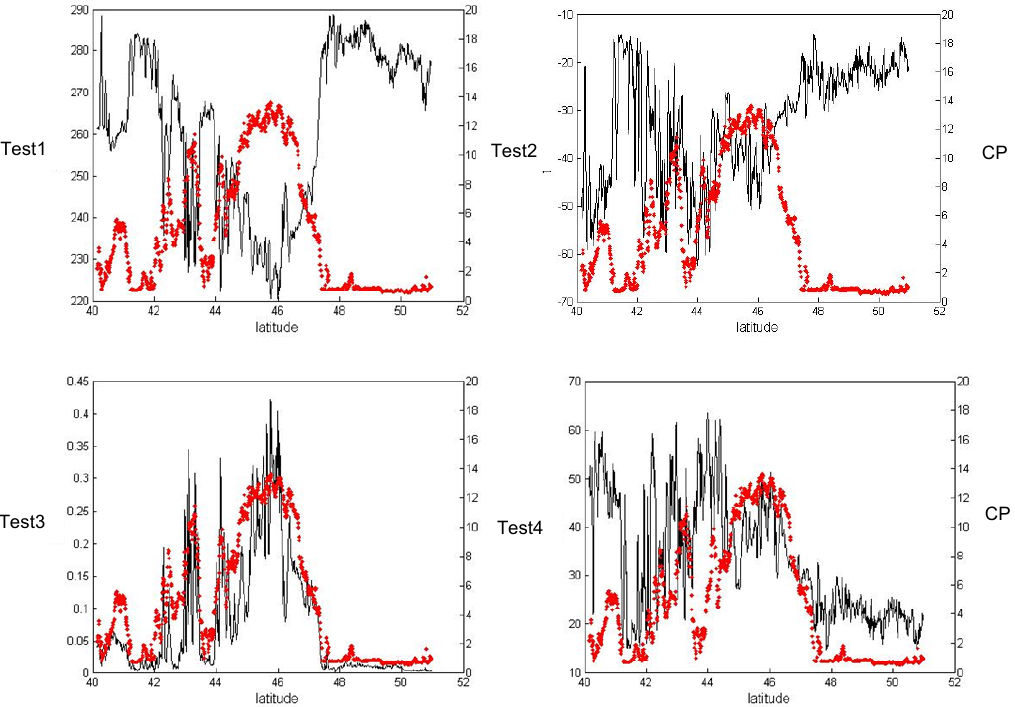
Figure 3. Comparison among the geo-located profiles of the different tests on MODIS data (black line) and the cloud profiles (CP) detected by CloudSat (red line). The data correspond to DOY 66 in 2008 characterized by extended cloud